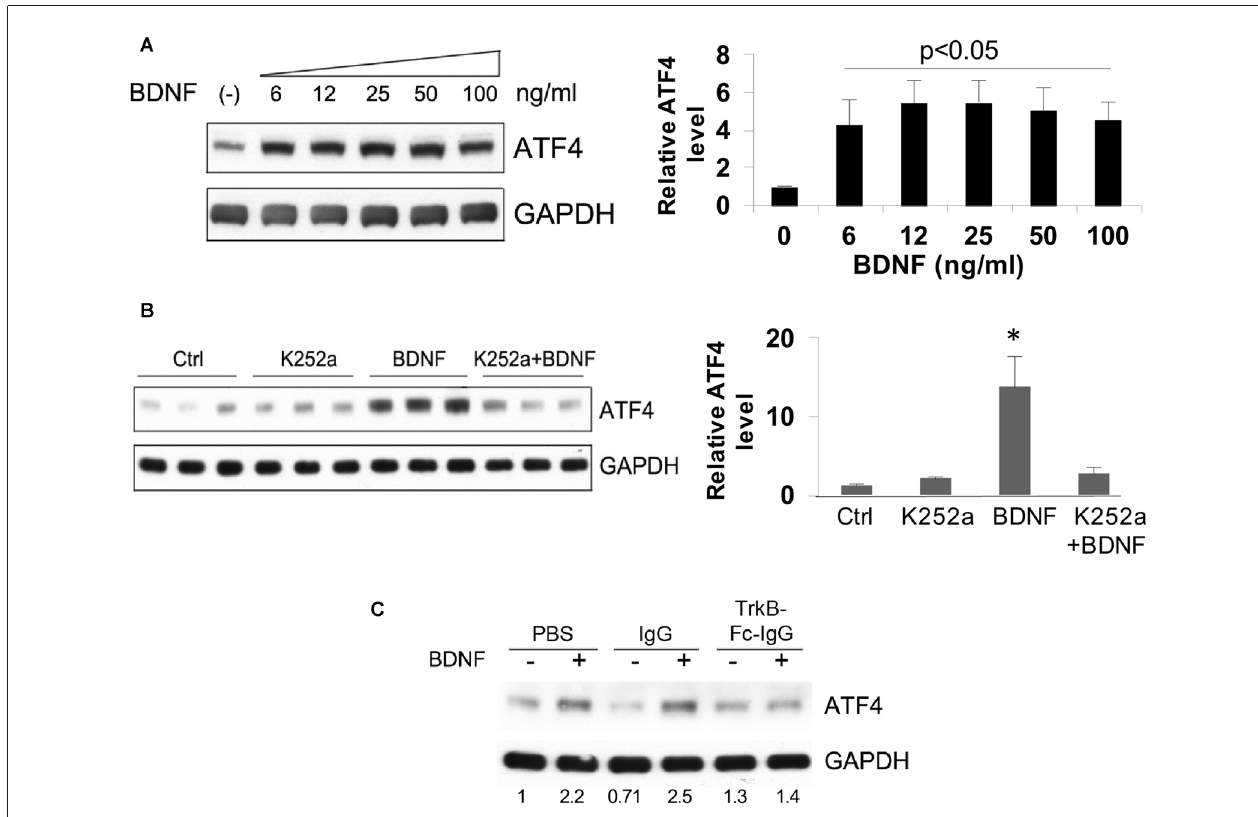
FIGURE 3 | Elevation of ATF4 protein levels by BDNF requires tropomyosin receptor kinase (TrkB). (A) BDNF upregulates ATF4 protein expression in a dose-dependent manner. Cultured hippocampal neurons were treated with the indicated concentrations of BDNF for 4 h at 12 DIV. Left panel shows representative Western immunoblot, right panel quantification (means ± SEM for six independent experiments, each performed with a single lysate per concentration). p values were calculated vs. no BDNF treatment, using the Kruskal-Wallis test (overall p = 0.038) with the post hoc Conover method adjusted by the FDR procedure of Benjamini-Hochberg and were 0.042 (6 ng/ml), 0.02 (12 ng/ml), 0.02 (25 ng/ml), 0.035 (50 ng/ml) and 0.035 (100 ng/ml). The test revealed no significant differences ( p = 0.9) in the values from 6 to 100 ng/ml BDNF. (B) Trk kinase inhibitor K252a blocks the upregulation of ATF4 caused by BDNF in hippocampal neuron cultures. Cultures were pre-treated ± K252a for 1 h and then exposed to 25 ng/ml BDNF for 4 h in presence or absence of the inhibitor. Left panel shows Western immunoblot, right panel shows quantification relative to untreated control (means ± SEM) from the same blot. ∗ p = 0.01 for control vs. BDNF, one-way ANOVA ( F = 8.3) using the post hoc Tukey HSD test. The same test revealed p = 0.9 for control vs. K252a+BDNF. Comparable results were found in an independent experiment. (C) TrkB-Fc-IgG blocks the elevation of ATF4 protein promoted by BDNF. Cultured hippocampal neurons were pre-treated with control IgG or TrkB-Fc-IgG fusion protein for 1 h then treated with 25 ng/ml BDNF for 4 h and assessed by Western immunoblotting for ATF4 expression. Numbers below bands show relative optical density normalized to GAPDH loading control. Comparable results were achieved with cultured cortical